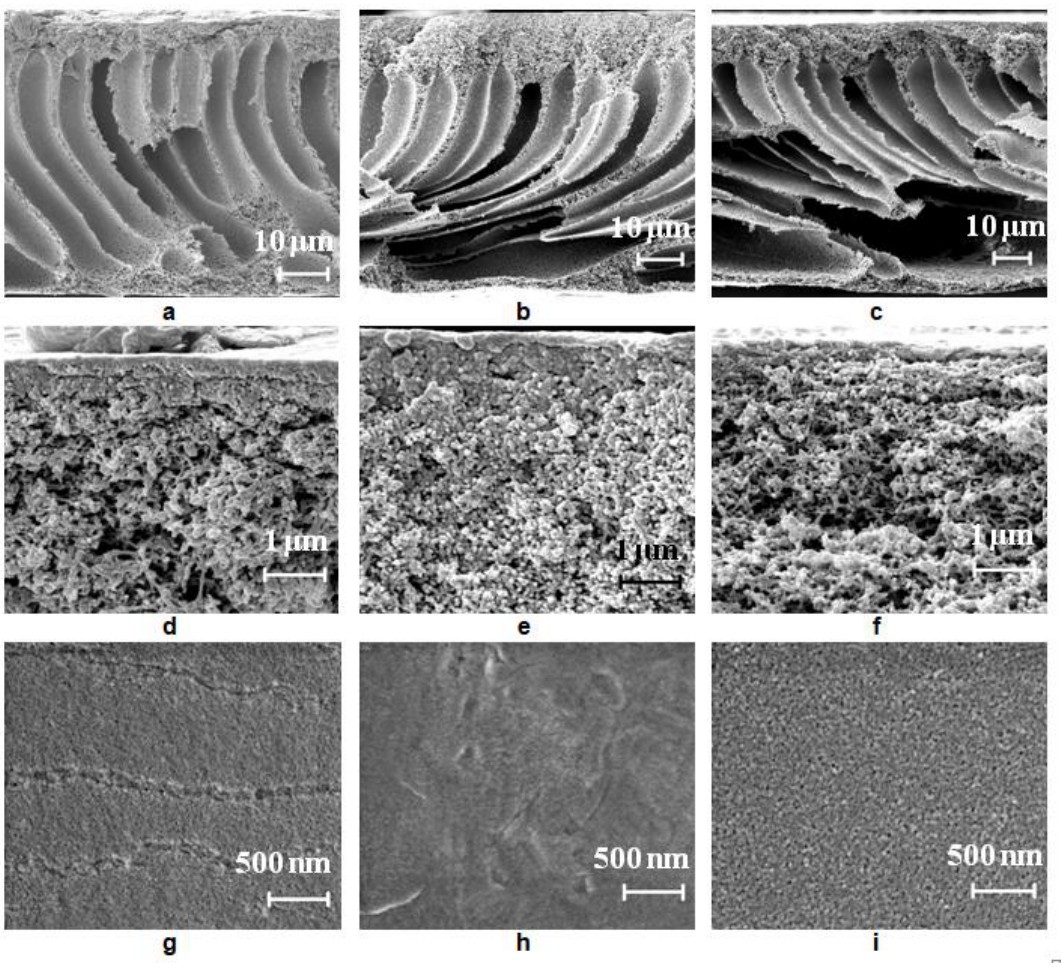
Figure 6. Scanning electron microscopy (SEM) images of the PSF membrane cross-section ( a–c ), selective layer ( d – f ), surface of the selective layer ( g – i ), prepared using a smooth glass plate, coagulation bath, T = 25 °C: (a,d,g) distilled water; (b,e,h) 0.05 wt.% Praestol 859 aqueous solution; (c,f,i) 0.3 wt.% Praestol 859 aqueous solution.